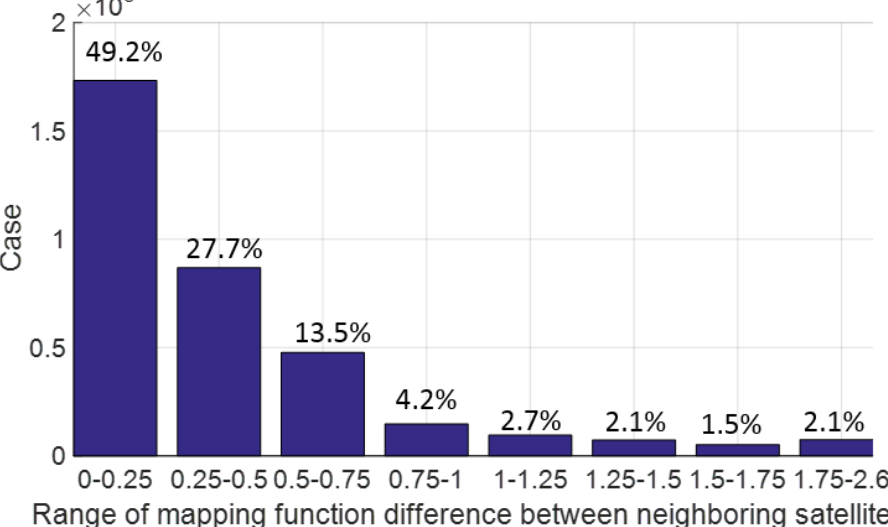
will be within 0.184 cycle.